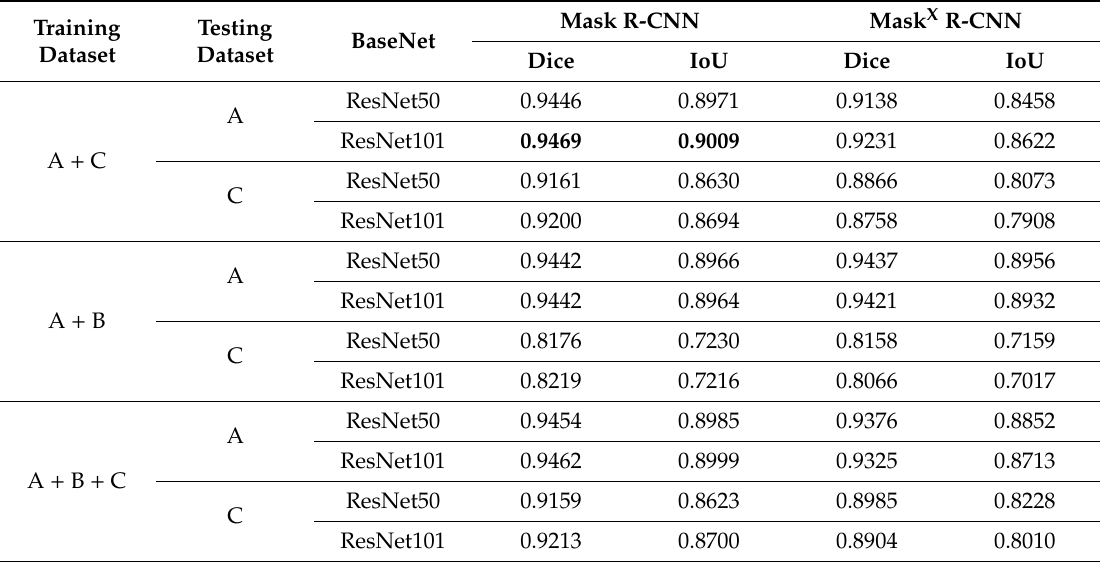
Table 7. Results when training with multiple datasets. The “(box)” denotes that only the bounding box annotations of this dataset are used in training; otherwise, mask annotations are used. Best results are highlighted in bold